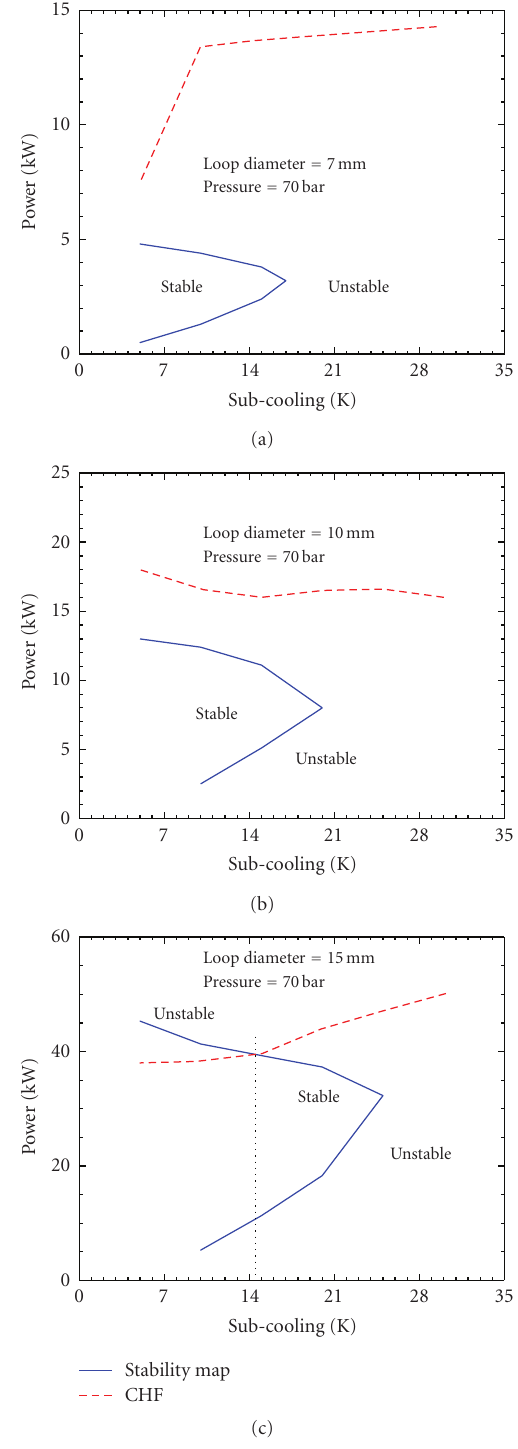
Figure 22: Stability controlled designs and loop